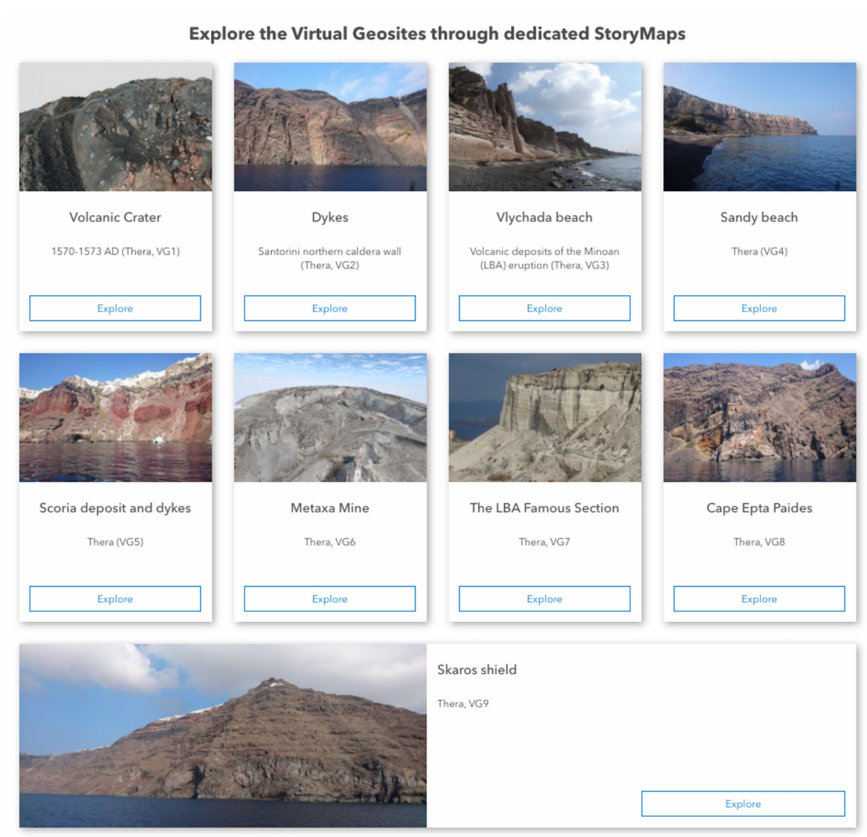
Figure 4. Screenshot showing the part of the hub where the users can access each VG. Using each button, the viewers can access, inside the hub, a dedicated StoryMap application, where descriptive text and the 3D model can be found.